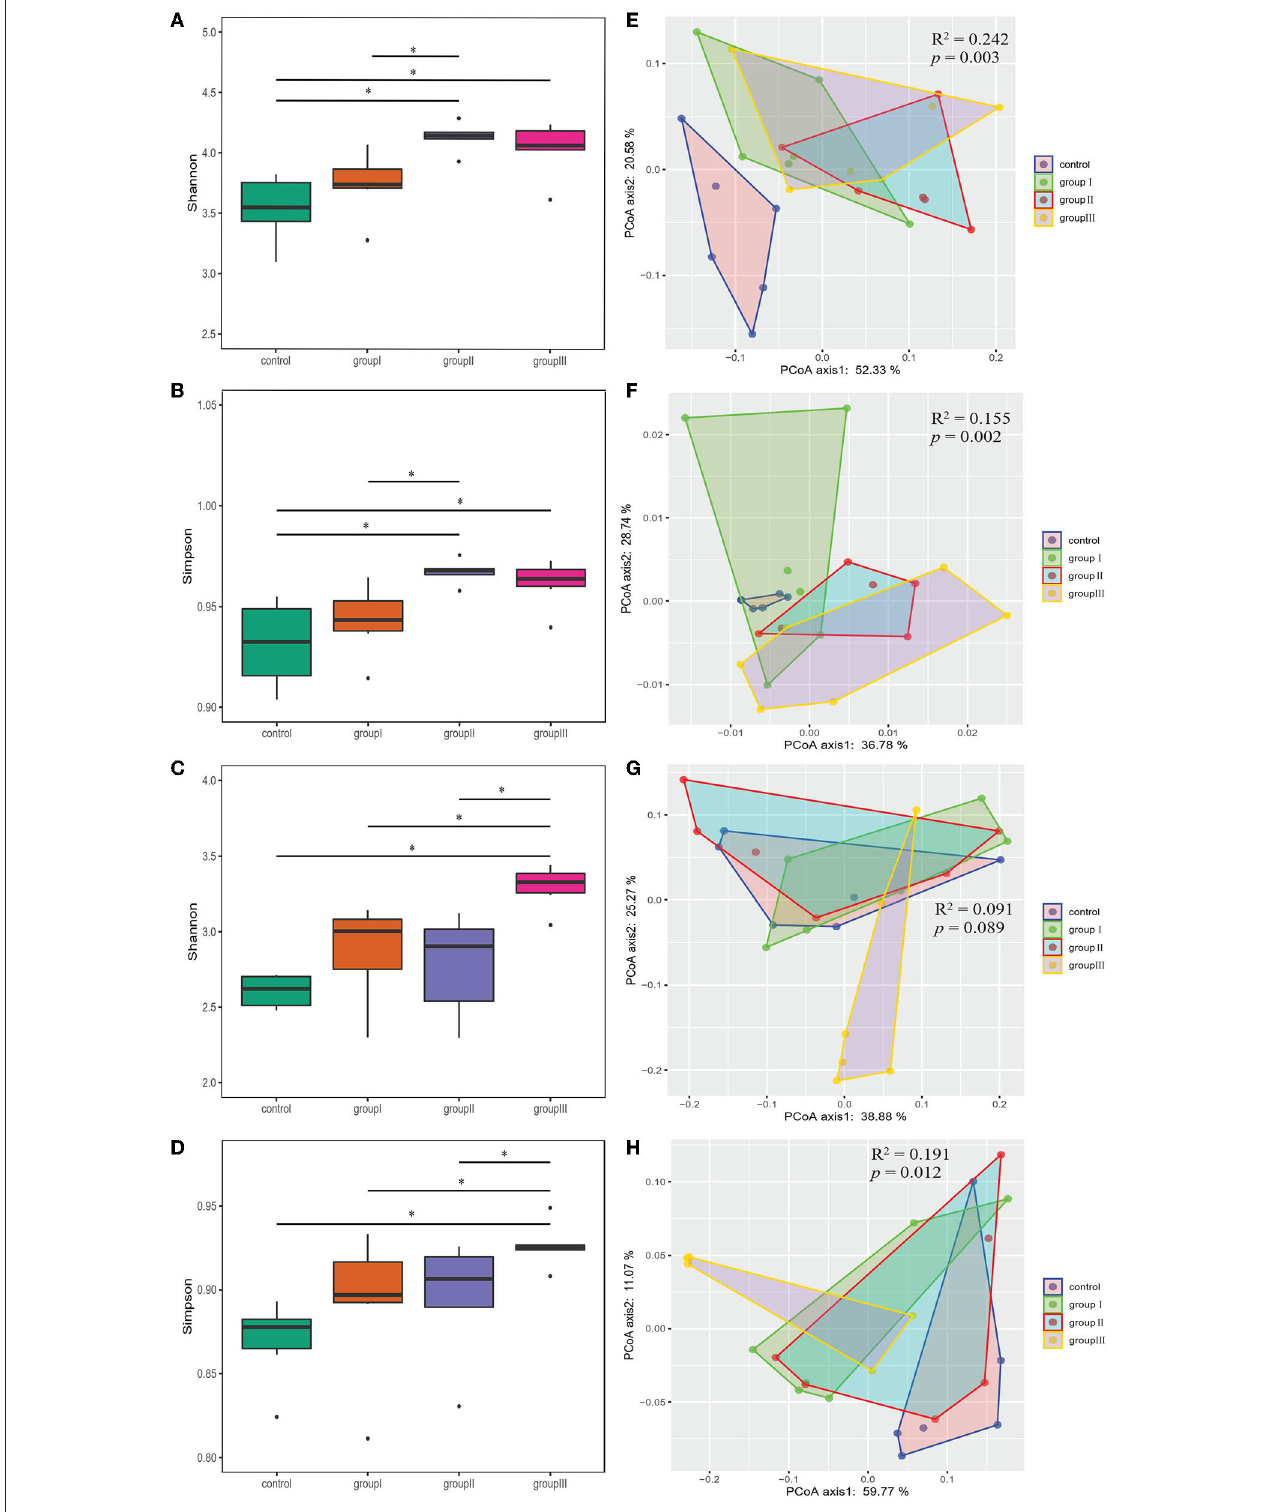
FIGURE 3 | Comparing α - and β -diversity of core bacteria from four dietary groups in two gut segments. Box plots showing significantly different Shannon (A) and Simpson (B) diversity indices among four dietary groups in the cecum (A,B) and jejunum (C,D) by Wilcoxon test. PCoA based on weighted (E,G) and unweighted (F,H) UniFrac distances for the cecum (E,F) and jejunum (G,H) bacterial populations. Adonis tests showed statistically significant differences among four dietary groups. * p < 0.05.